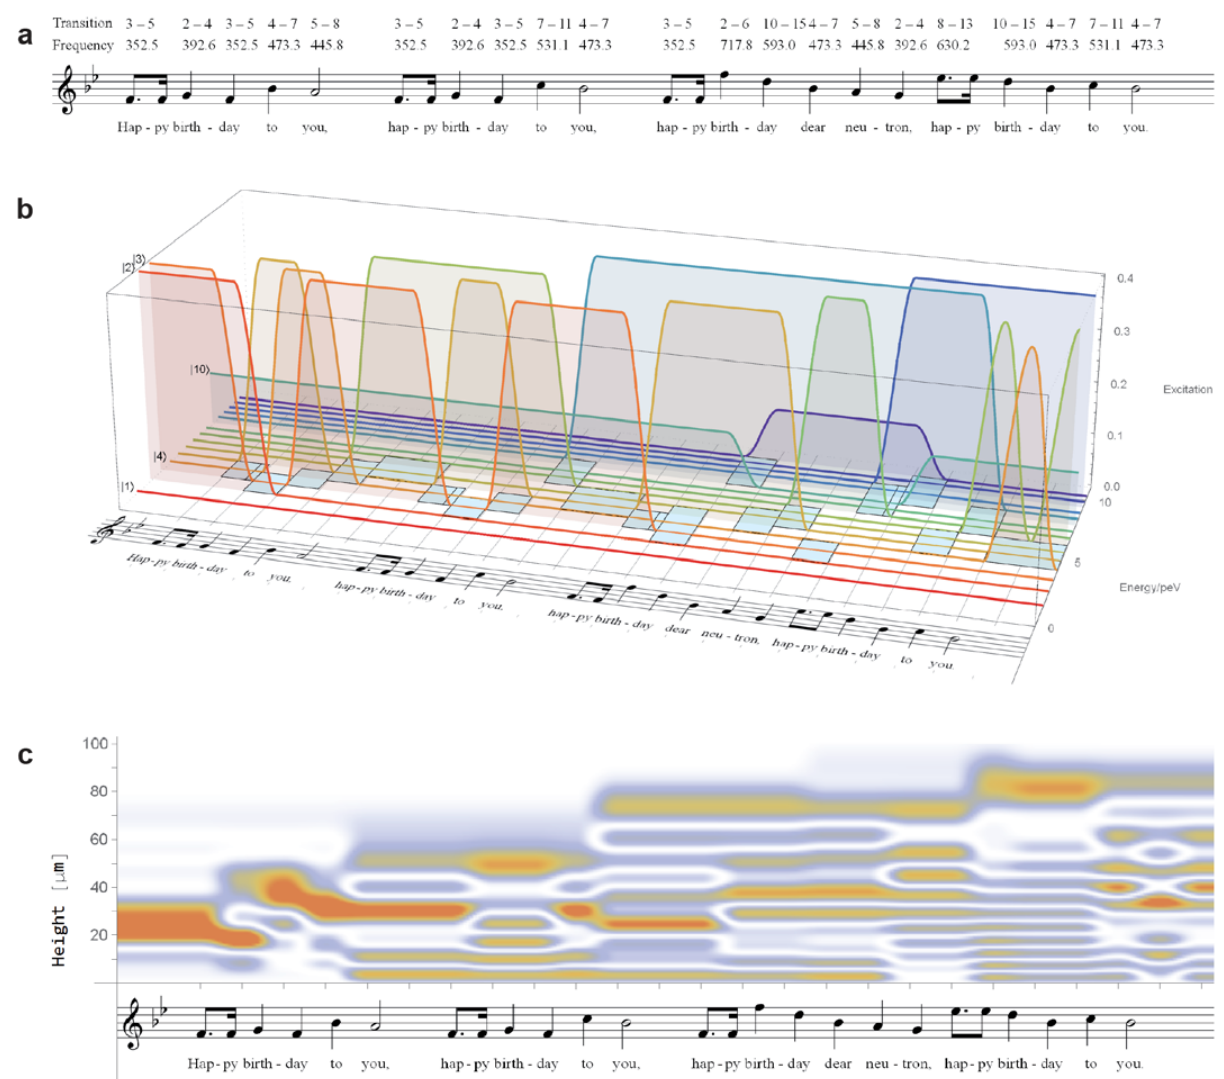
Figure 8. A birthday song for ultra-cold neutrons. (a) Level couplings and frequencies used for the birthday song. (b) Each song note couples two levels, indicated by the light blue rectangles. As long as the note is sounding the level amplitudes make a Rabi oscillation. The tone duration of a quarter note creates a π flip. (c) Neutron wave function | ψ | 2 of the dancing